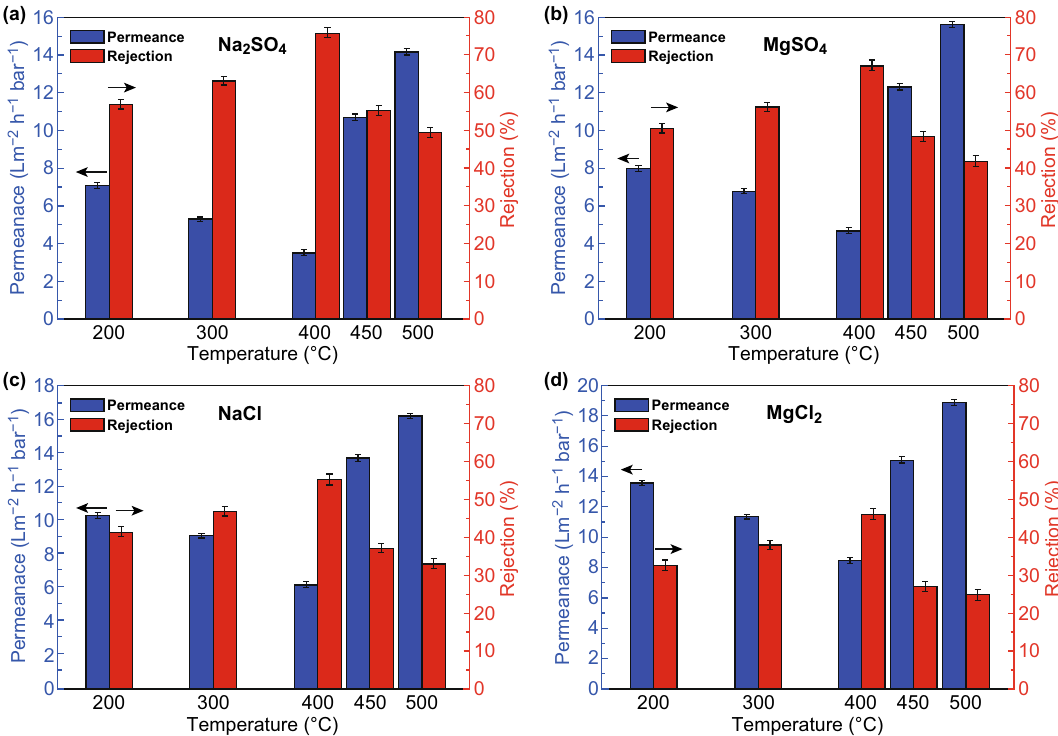
Fig. 7 a – d Rejections and salt permeances of the MXene membranes. Reprinted with permission from Ref. [54]. Copyright © (2019) Elsevier